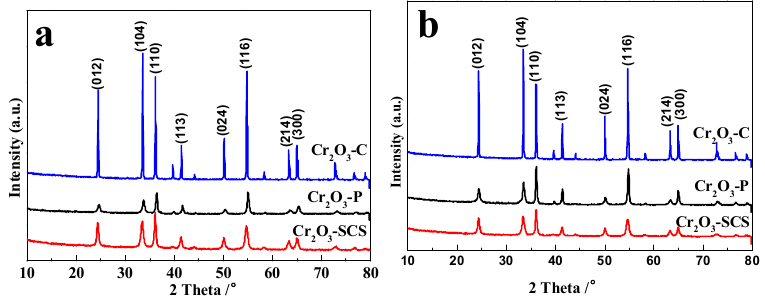
Figure 3. X-ray diffraction spectra for fresh Cr 2 O 3 catalysts ( a ) and spent catalysts ( b ) prepared by different methods. Table 1. Crystal size changes of fresh and spent Cr 2 O 3 catalyst prepared by different methods.